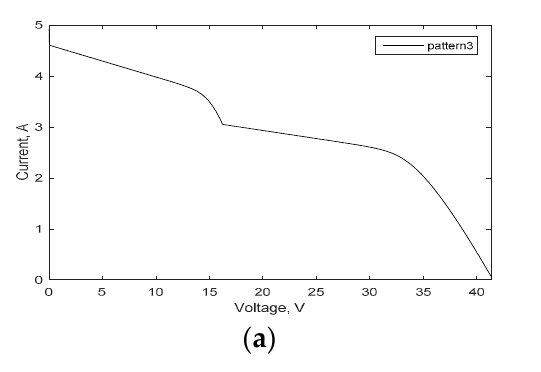
Figure 8. Characteristic curves of PV panel for pattern 3: ( a ) P-V, ( b ) I-V.